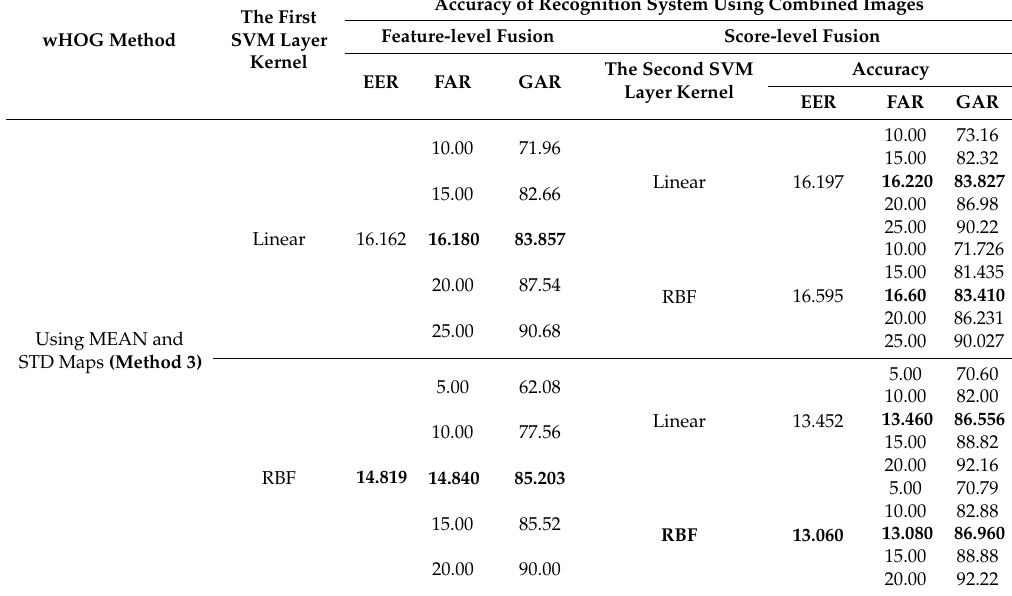
Table 9. Recognition accuracies of our proposed method (using MEAN map for quality assessment of image regions of visible light images and the STD map for quality assessment of image regions of thermal images) using feature-level fusion and score-level fusion approaches (unit: